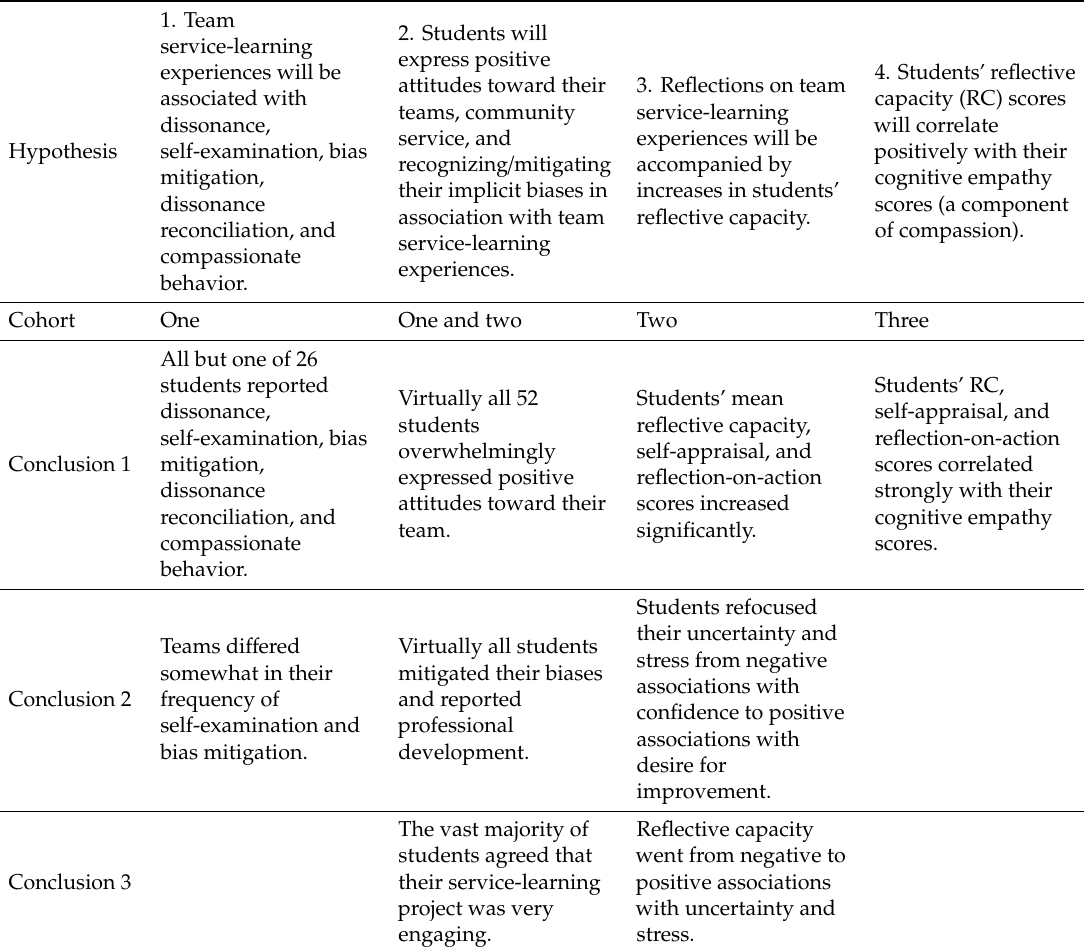
Table 6. Summary of findings /